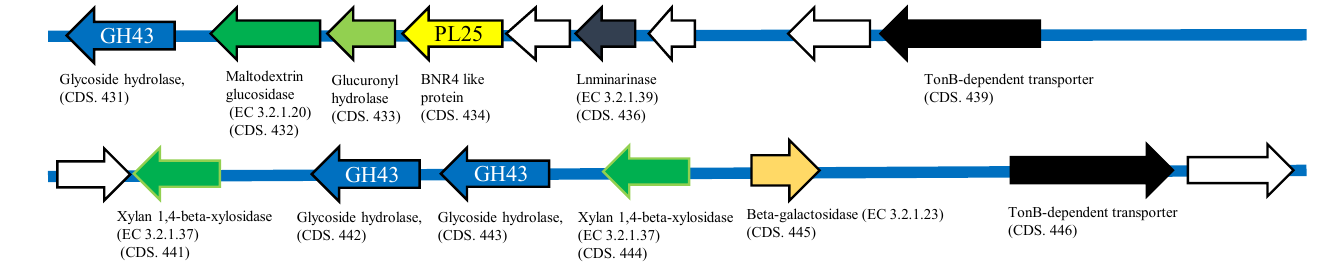
Figure 5. Reaction time course (235 nm) of ulvan and cell-clashed solutions (( A ), Alteromonas sp. ul20-2; ( B ), Vibrio sp. 10N; ( C ), Echinicola sp. 20G; ( D ), negative control).